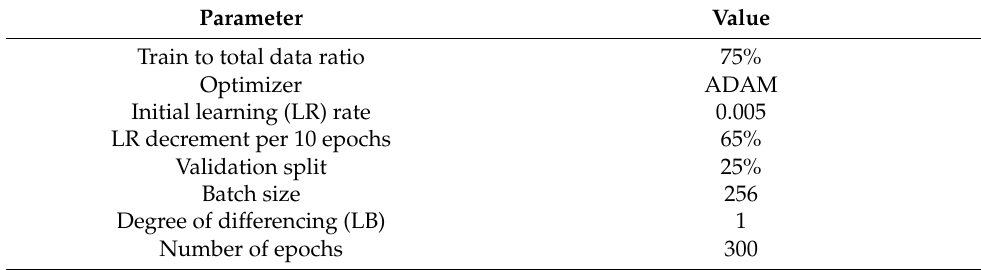
Table 5. Tuned hypermeters and model inputs for the parameter prediction in months span with